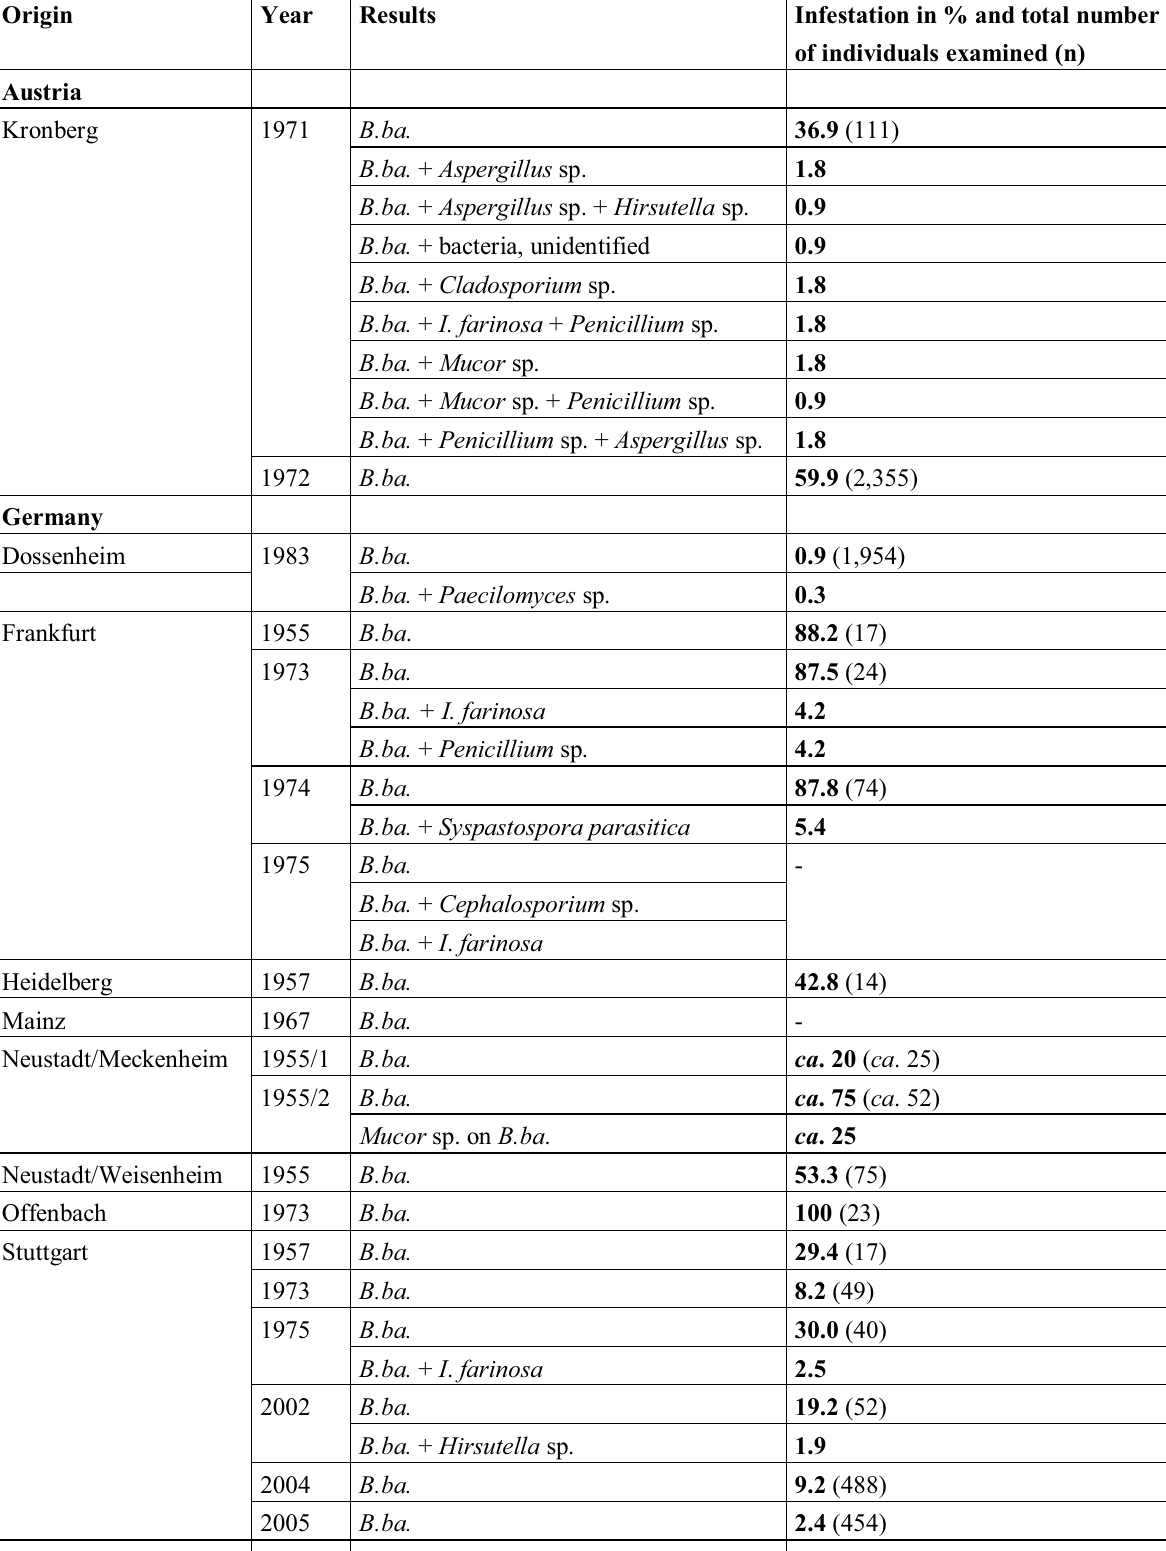
Table 3. Occurrence and prevalence of the entomopathogenic fungus, Beauveria bassiana ( B.ba. ), in C. pomonella (larvae and pupae; the origin mostly refers to the address of the sender and not always to the location of the codling